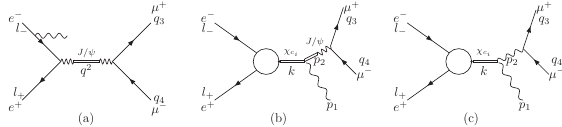
Figure 1. Diagrams for the cross section for the process e + e −